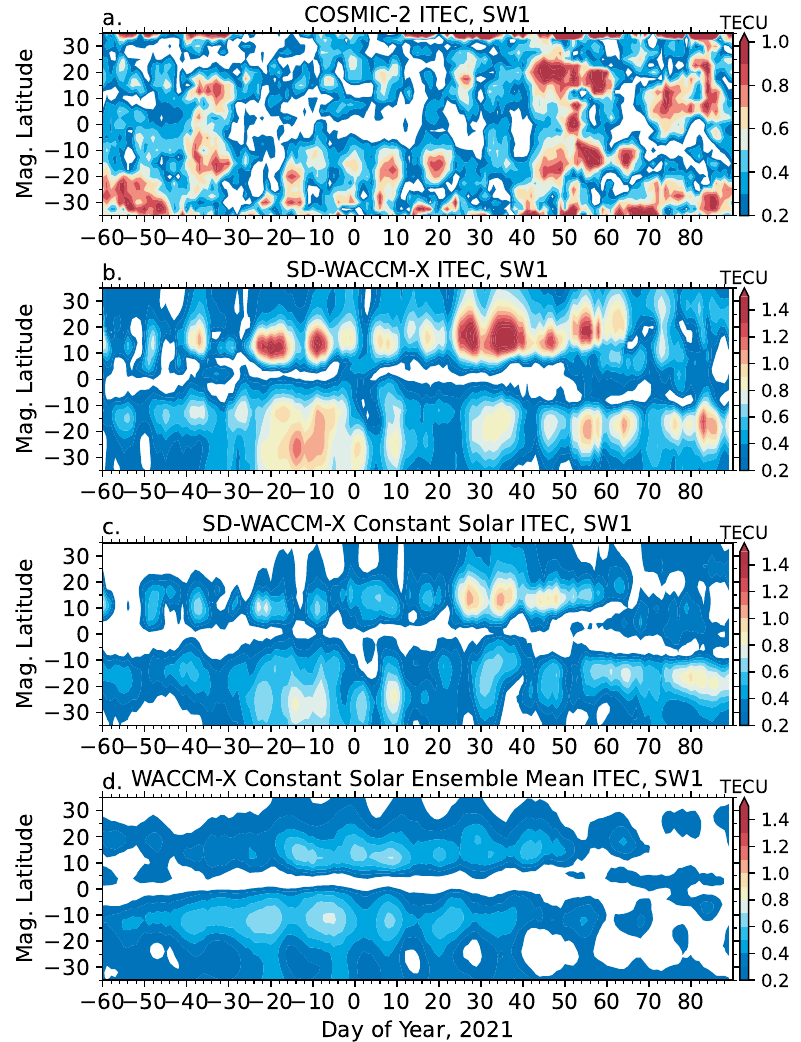
Figure 6. SW1 amplitude in ITEC from ( a ) COSMIC-2 observations, ( b ) SD-WACCM-X, ( c ) SD- WACCM-X Constant Solar, and ( d ) WACCM-X Constant Solar Ensemble